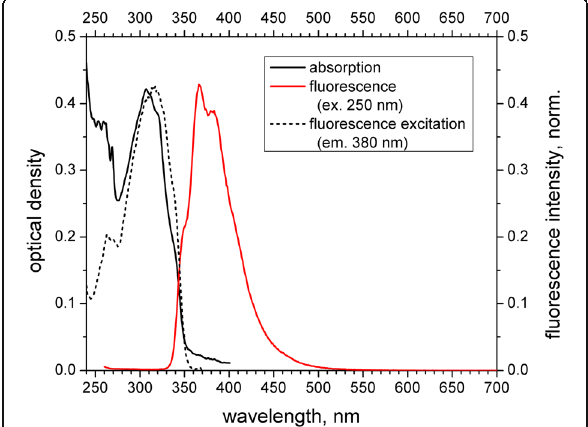
Fig. 3 Absorption (black solid line), fluorescence excitation (emission at 380 nm, normalized; black short-dashed line), and emission (excitation at 250 nm, normalized; red solid line) spectra of the obtained PS-PPO-PNIPAM hybrid nanosystems in 50 mM Tris-HCl buffer (pH